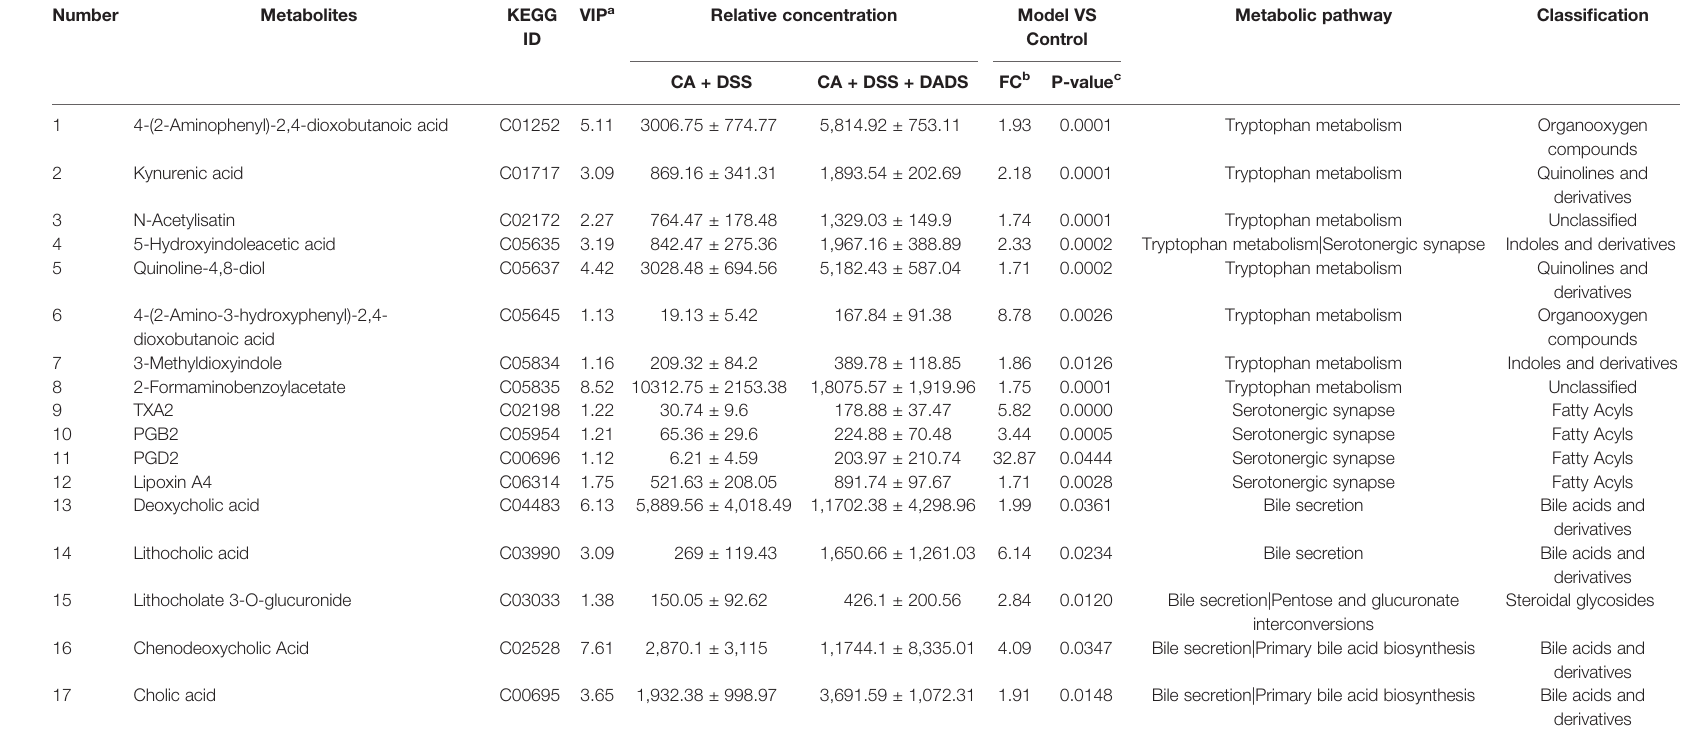
TABLE 3 | Differential fecal metabolites and relevant pathways between two